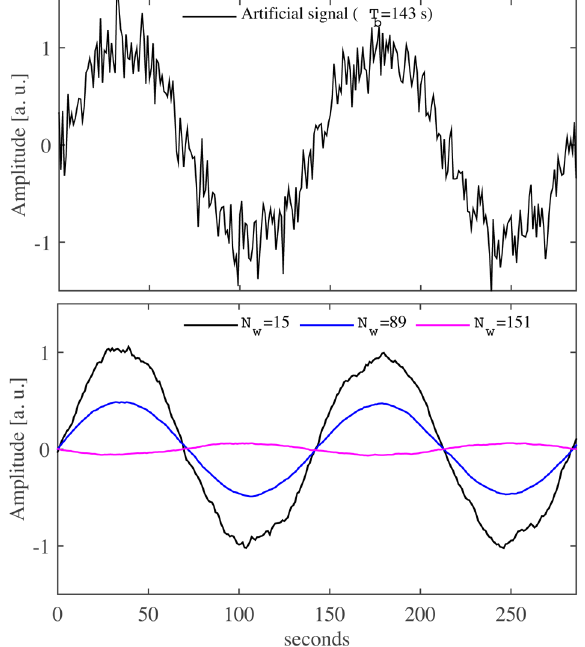
Figure 2. A moving-average procedure example. Top panel shows the original artificial signal composed by normally distributed white = 143 s) sine wave. Bottom panel shows the noise and a 7 mHz ( T b result after the moving-average procedure, for three different win- ). The sampling period is h = 1 dow sizes ( N w